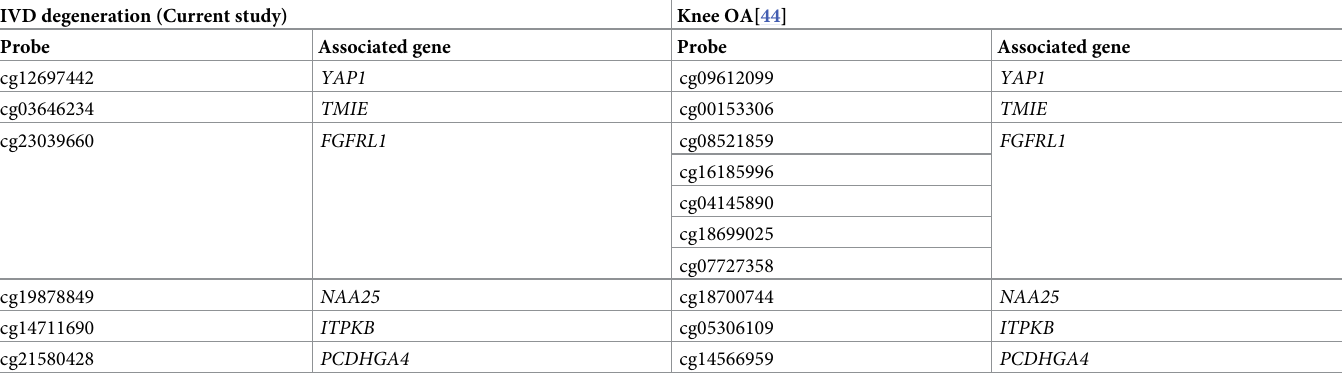
Table 3. Overlap of differentially methylated loci (DMLs) identified in human IVD degeneration and human knee osteoarthritis (OA). IVD degeneration (Current study) Knee